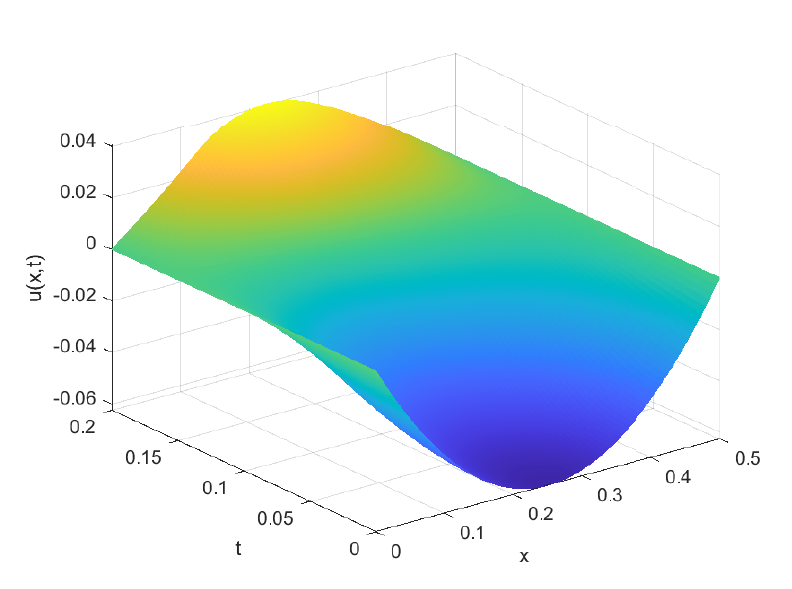
Figure 3. Reference solution for Example 2 computed by the finite difference method (FDM) (36).